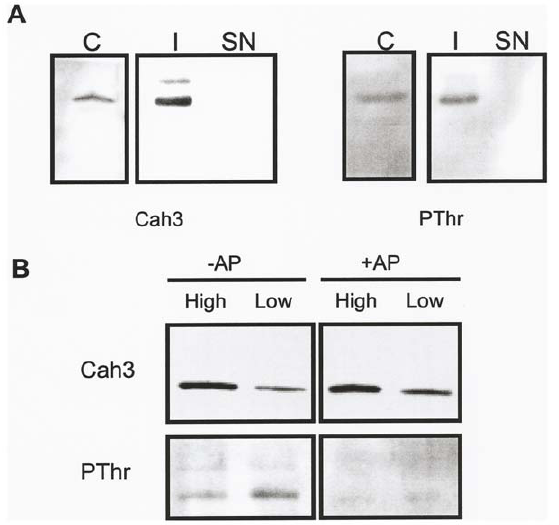
Figure 4. Immunoprecipitation and dephosphorylation exper- iments of extrinsic thylakoid polypeptides. Extraction of extrinsic thylakoid proteins was accomplished by washing the thylakoid membranes with a medium containing low concentrations (0.05%) of Triton X-100. ( A ) The 30-kDa extrinsic phosphoprotein immunoprecip- itates with Cah3. Extrinsic thylakoid proteins released from thylakoid membranes of C. reinhardtii cells acclimated to low CO 2 for 2 h (C) were immunoprecipitated with affinity-purified antibodies against Cah3 and protein A-Sepharose CL-4-B beads. The Sepharose beads were washed and the immunoprecipitate (I) and the supernatant (SN) obtained after centrifugation were analysed by SDS-PAGE and immunoblot and probed with antibodies against Cah3 (left) and Thr(P) (right). ( B ) Effect of Alkaline phosphatase (AP) treatment on extrinsic proteins released from thylakoid membranes isolated from both high-CO 2 -grown cells (High) or cells acclimated to low CO 2 for 2 h (Low). All lanes were loaded with 10 m g protein.